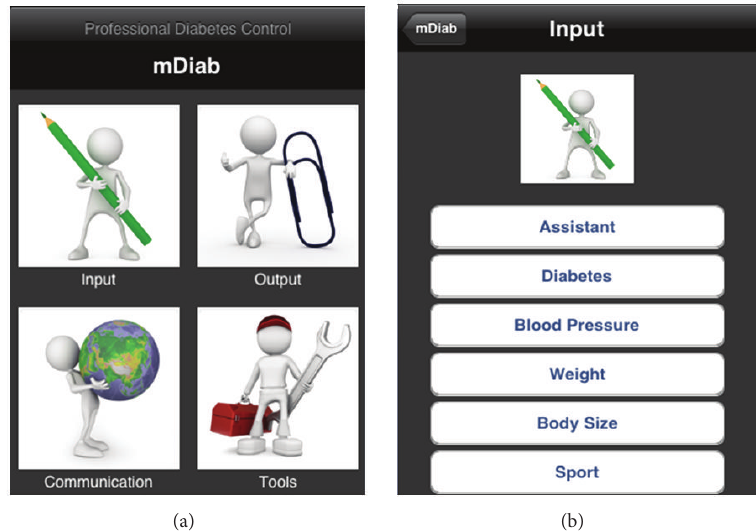
Figure 2: Mobil Diab mobile application: screenshots of the main screen and the input